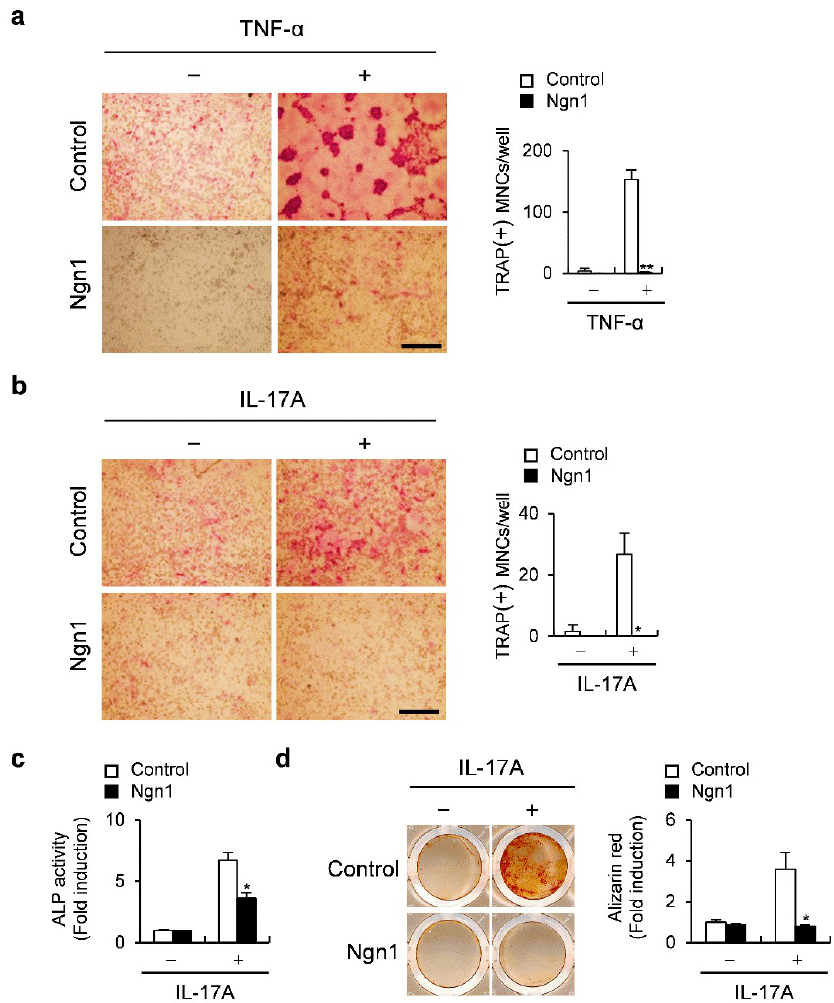
Figure 5. The overexpression of Ngn1 inhibited the osteoclastogenesis and osteoblastogenesis mediated by inflammatory cytokines. ( a ) BMMs overexpressing Ngn1 were generated via retroviral infection and subsequently incubated with M-CSF, RANKL, and TNF-α for 3 days. TRAP-stained cells (left panel) and the number of TRAP-positive multinucleated cells (right panel), scale bar: 200 µm. ( b ) BMMs overexpressing Ngn1 were generated via retroviral infection and subsequently incubated with M-CSF, RANKL, and IL-17A for 3 days. TRAP-stained cells (left panel) and the number of TRAP-positive multinucleated cells (right panel), scale bar: 200 µm. ( c , d ) Osteoblast precursor cells overexpressing Ngn1 were generated via retroviral infection and subsequently cultured with ascorbic acid, β-glycerophosphate, and IL-17A. ( c ) Levels of ALP in cells cultured for 3 days. ( d ) Cells were cultured for 6 days, stained with alizarin red (left panel), and those positive for alizarin red were quantified (right panel). * p < 0.01, ** p < 0.001 vs. control.